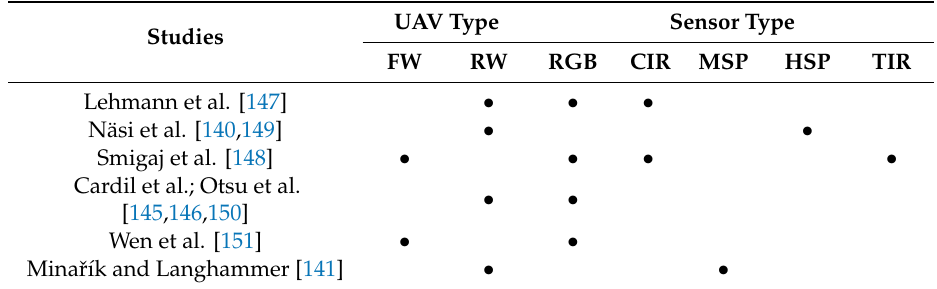
Table 5. Compilation of the studies reviewed in this subsection summarized by their main objectives, conclusions and UAV type and sensors used in each